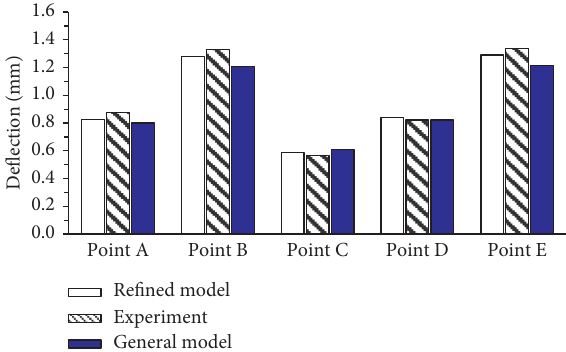
Figure 28: Comparison of the deflections between the experiment and FE models.